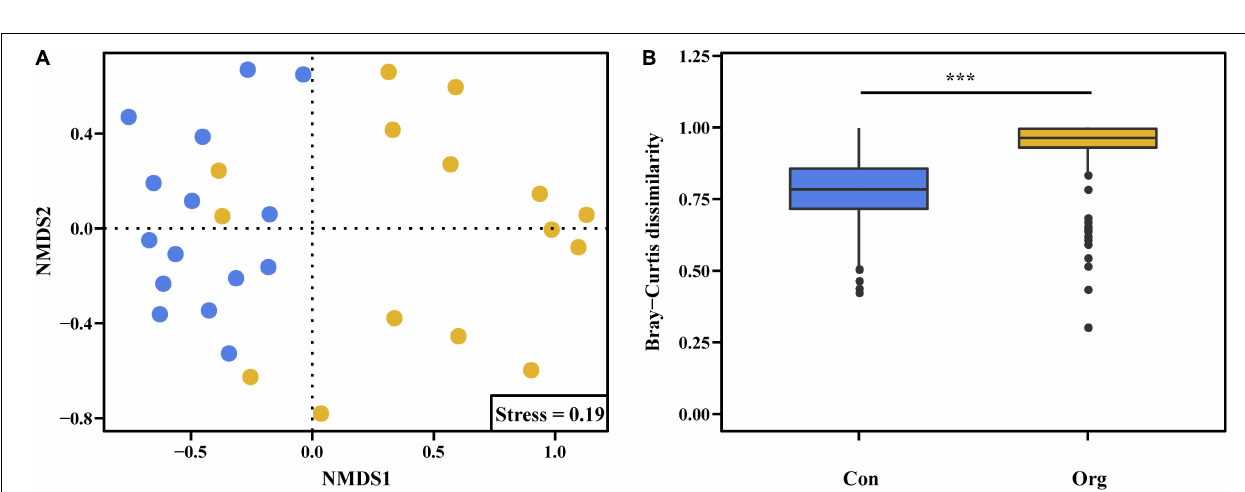
Frontiers in Microbiology |